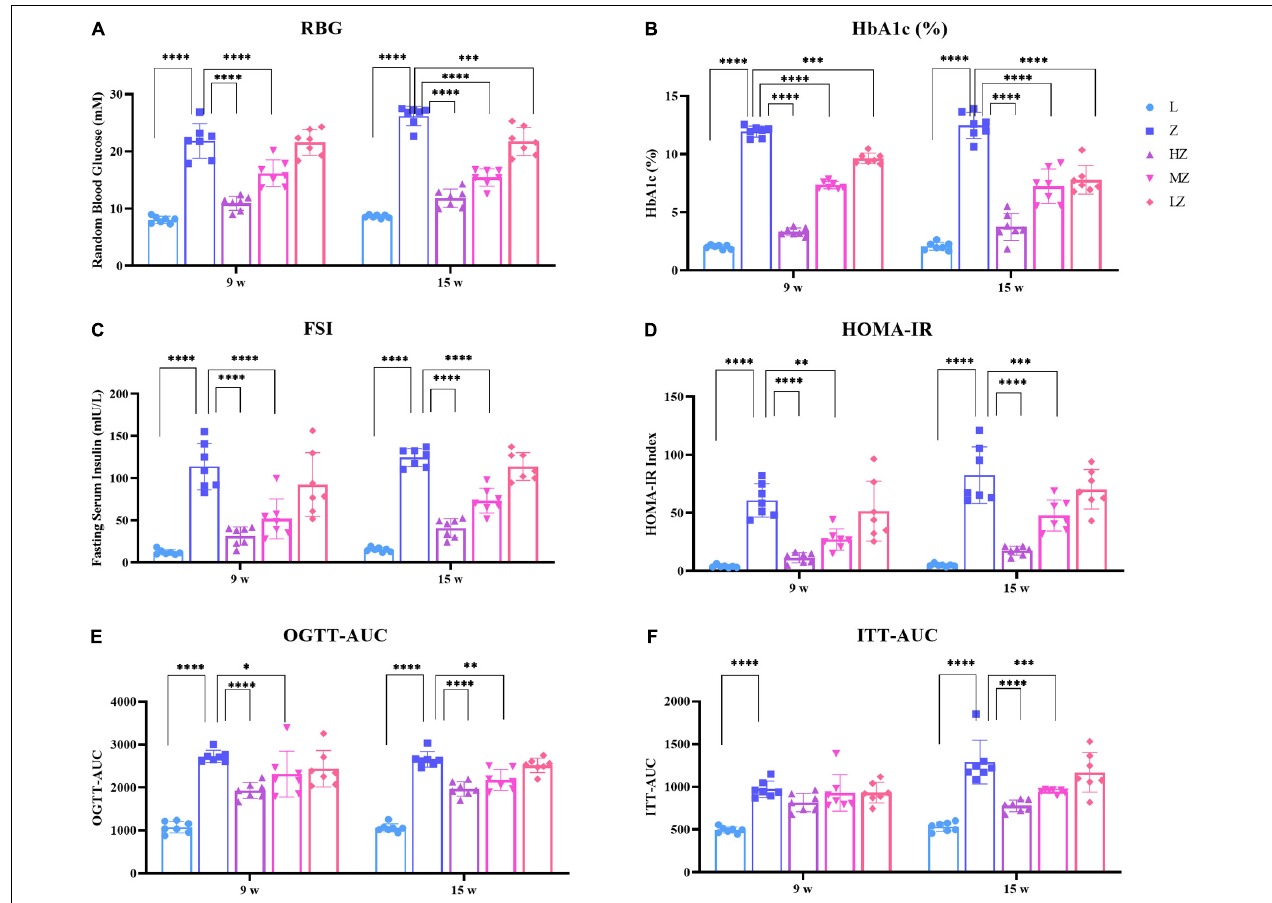
FIGURE 2 | Effect of ZBPYR on the phenotype of glucose metabolism in rats. (A) Random blood glucose (RBG). (B) Glycosylated hemoglobin (HbA1c%). (C) Fasting serum insulin (FSI). (D) Homeostasis model of assessment for insulin resistance (HOMA-IR) index. (E) Area under the curve of the oral glucose tolerance test (OGTT-AUC). (F) Area under the curve of the insulin secretion test (ITT-AUC). Data are shown as mean ± SD. n = 7 per group. * p < 0.05, ** p < 0.01, *** p < 0.001, **** p <